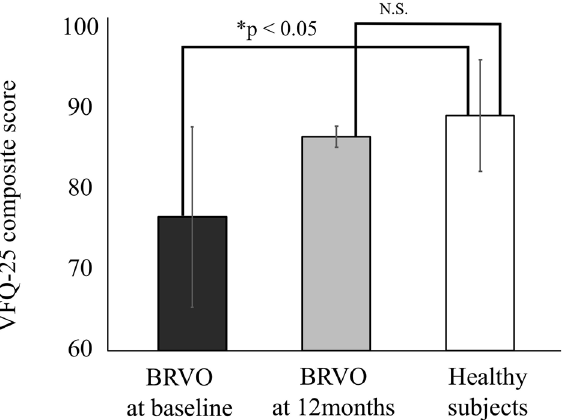
Figure 3. The VFQ-25 composite score in patients with BRVO before and after treatment and in healthy control subjects. *Mann–Whitney U test, N.S. not significant.